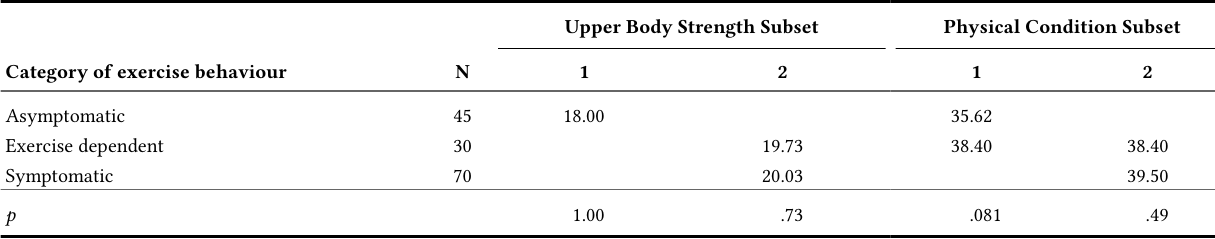
Post-Hoc Duncan’s Homogenous Subtests for Upper Body Strength and Physical Condition for Male Gym-Goers Upper Body Strength Subset Physical Condition Subset Category of exercise